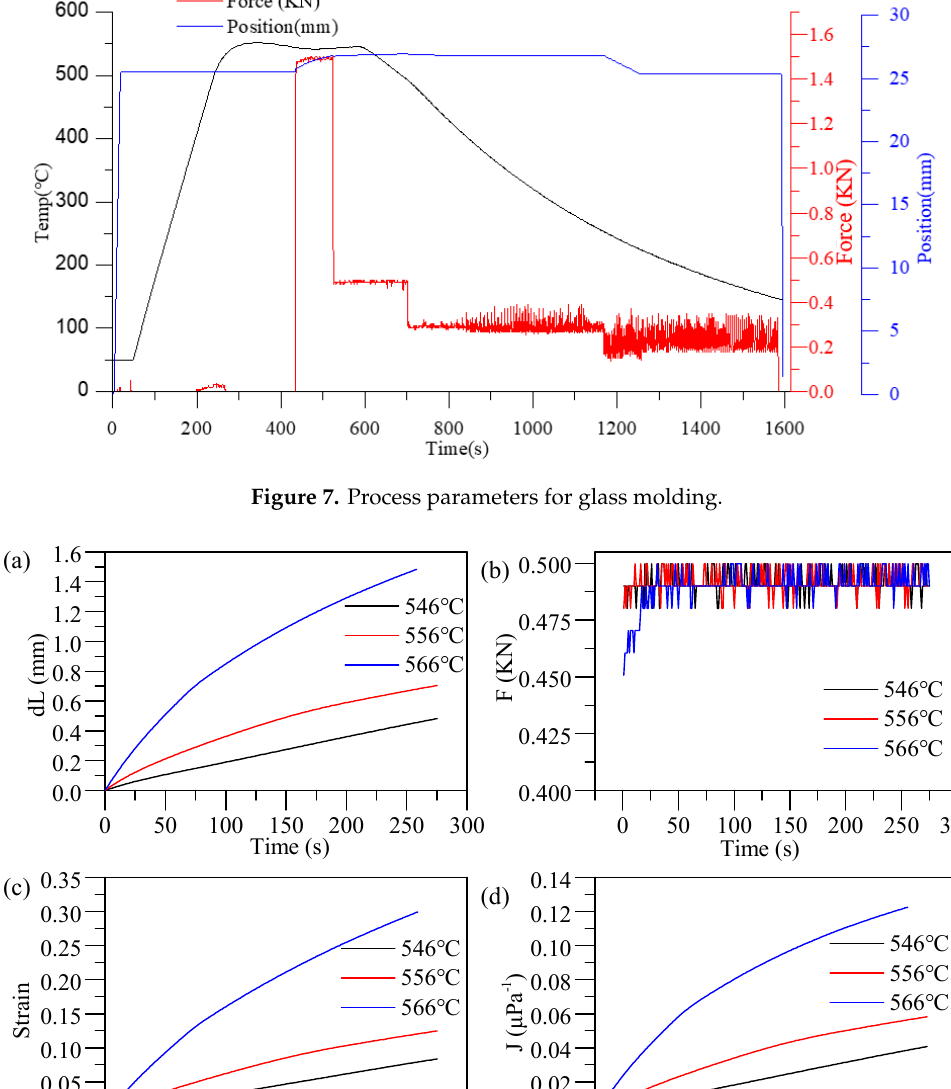
Figure 6. Setup of glass molding.